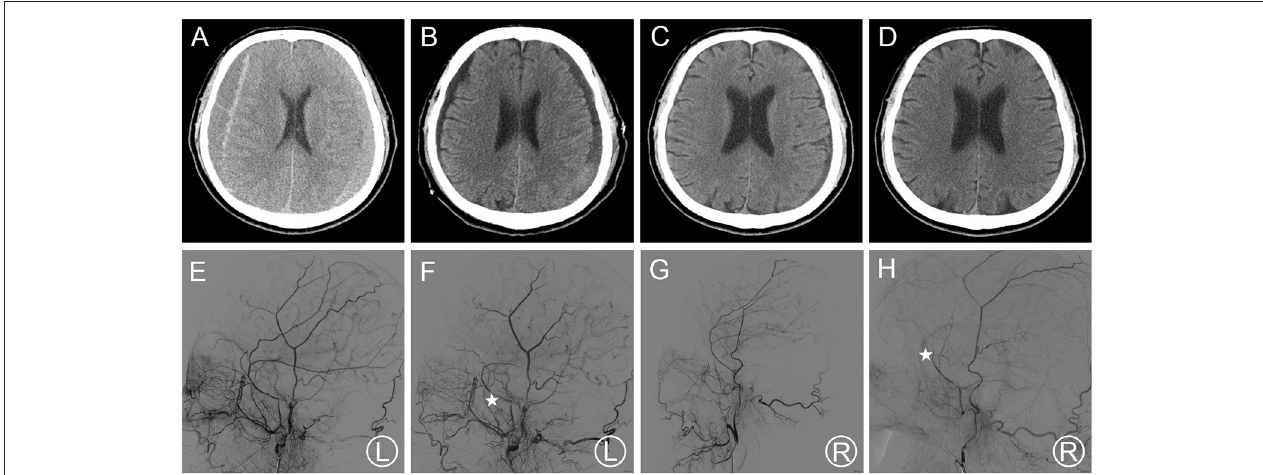
FIGURE 1 | (A) Brain CT images of a hematoma in patient 1 before treatment. (B) Brain CT was repeated before the patient’s discharge. (C,D) Follow-up brain CT was performed at 35 and 115 days. (E,F) Pre- and post-operative DSA presented left MMA and the left MMA disappeared (asterisk). (G,H) Pre- and post-operative DSA presented right MMA and the right MMA disappeared (asterisk). DSA, digital subtraction angiography; CT, computed tomography; MMA, middle meningeal artery.